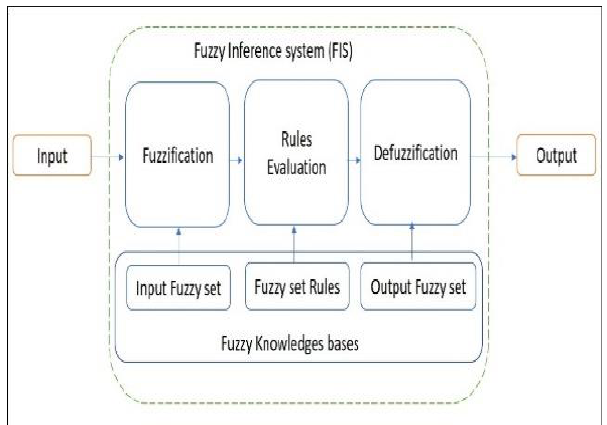
Figure 4. Proposed Fuzzy Inference System for